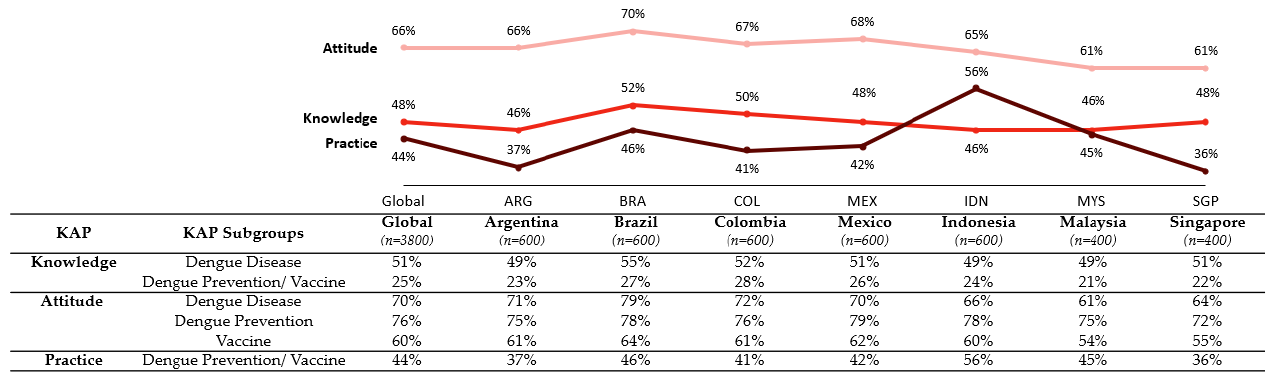
Figure 2. Knowledge, Attitudes, and Practices overall composite score and individual factor scores globally and by country.